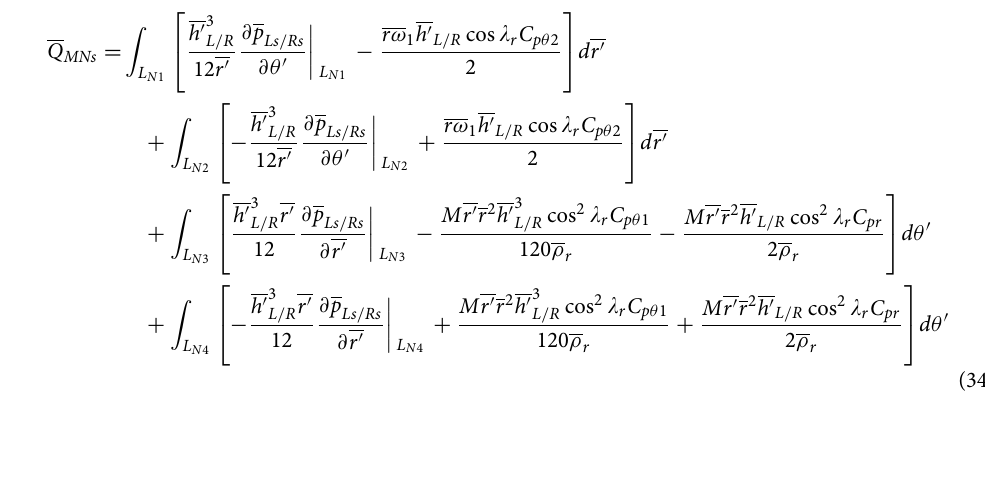
Substituting Eqs. (23), (31) into Eq. (32), the static and perturbed flow conservation equation can be calcu- lated by